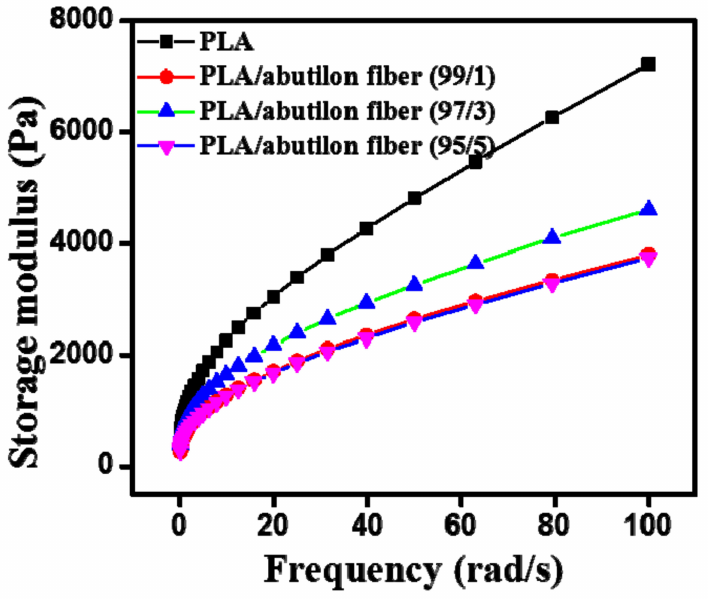
Figure 9. Storage modulus of (PLA / abutilon fiber) composites.